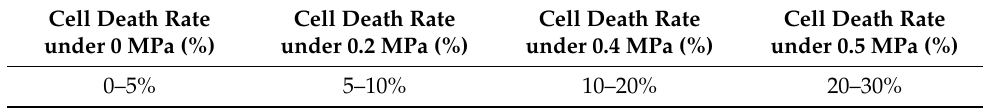
Figure 7. Cell survival states in the gelatin/alginate/agarose hydrogel under different extrusion pressures. ( a ) Under a pressure of 0 MPa. ( b ) Under a pressure of 0.2 MPa. ( c ) Under a pressure of 0.4 MPa. ( d ) Under a pressure of 0.5 MPa. Table 4. The cell death rate under different extrusion pressures.